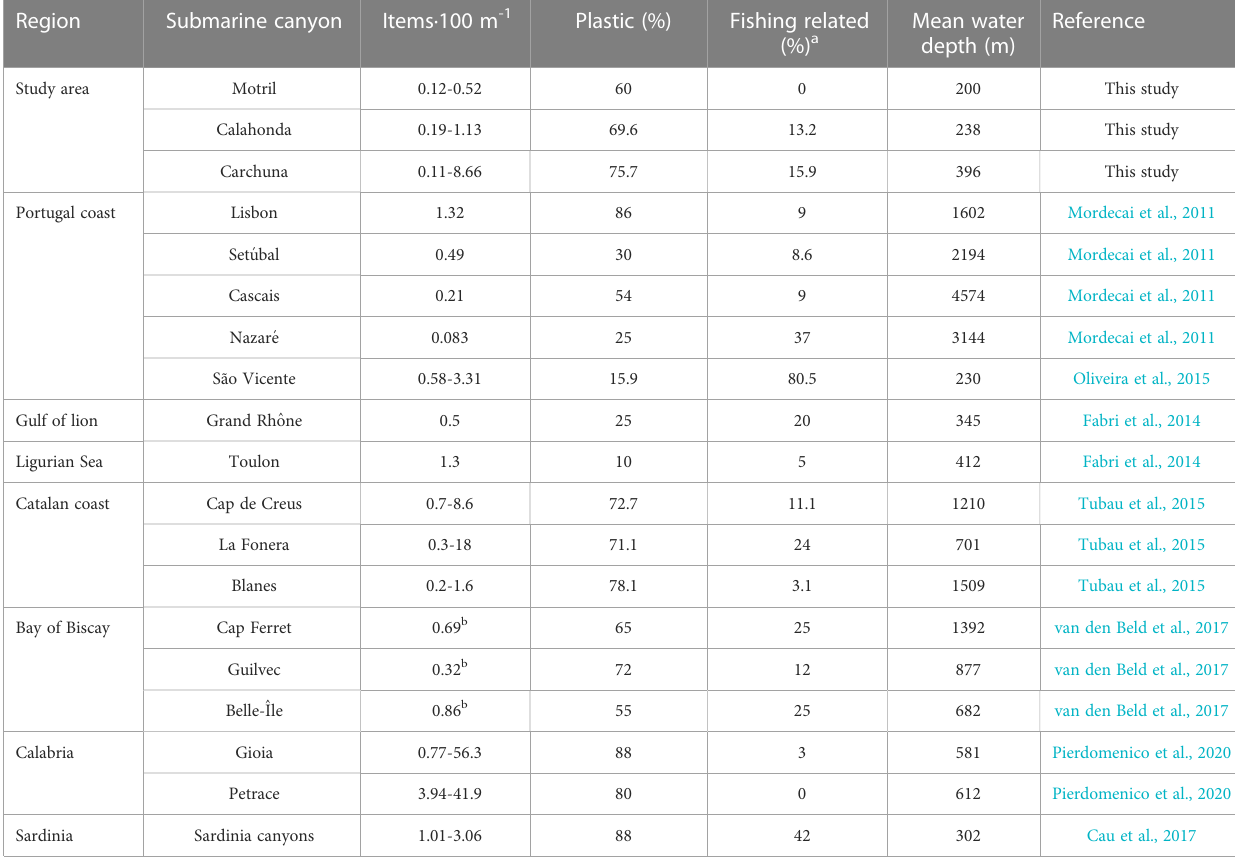
TABLE 4 Values of density of marine litter reported in linear measurements in different submarine canyons of the Atlantic Ocean and the Mediterranean Sea. Region